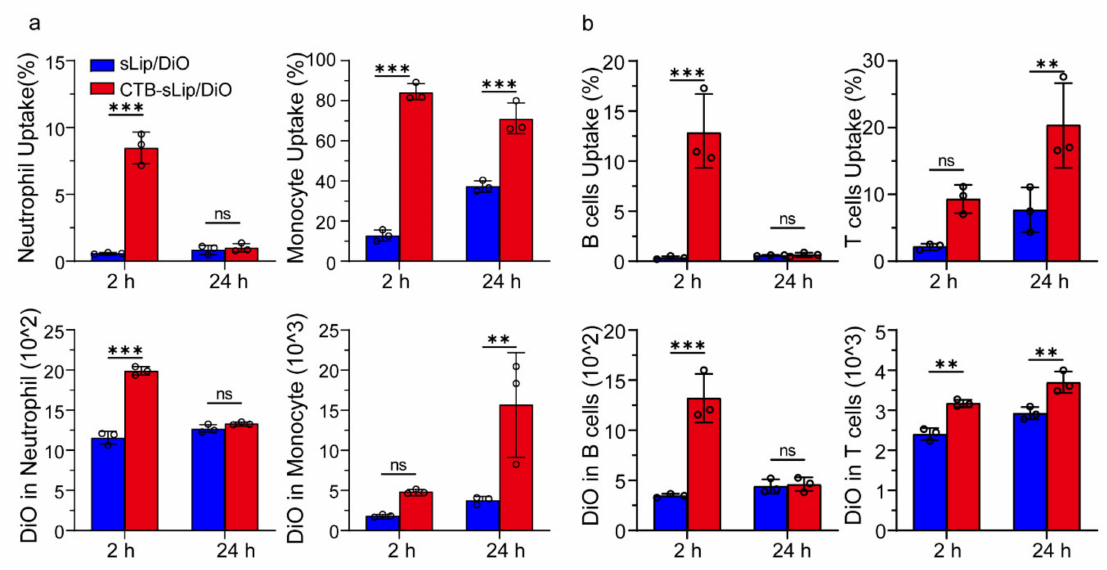
Figure 6. Uptake of CTB-sLip by blood white cells of BALB/c mice in vivo. CTB-sLip/DiO were injected with 50 mg kg − 1 lipids. Uptake by neutrophils and monocytes ( a ), and T cells and B cells ( b ) in peripheral blood at 2 h and 24 h after injection was determined by Flow Cytometry. Data are means ± SDs ( n = 3). ** p < 0.01, *** p < 0.001; ns indicates nonsignificant based on grouped two-way